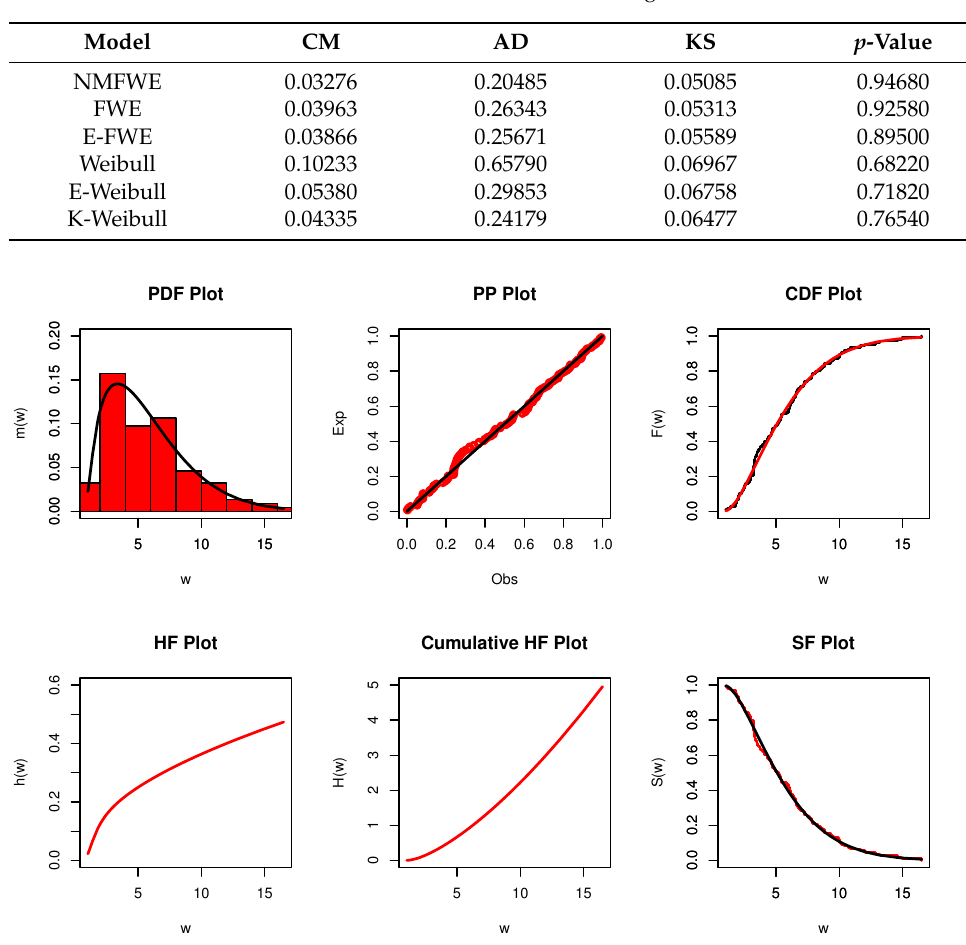
Table 6. The values of CM, AD and KS of the fitted models, using the first COVID-19 dataset.